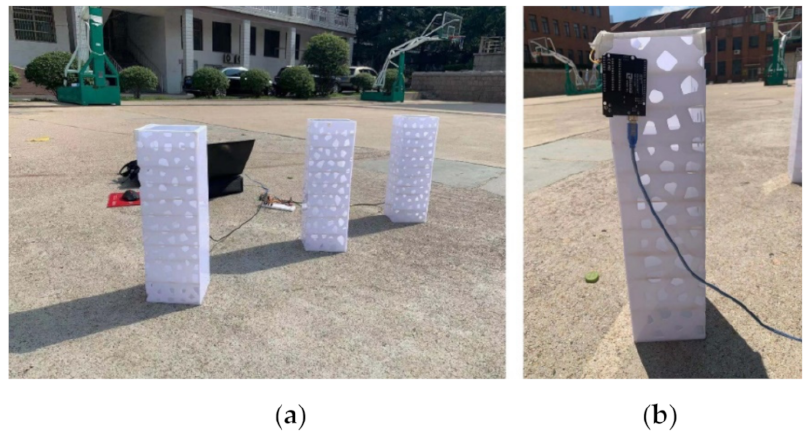
Figure 17. ( a , b ) Physical models with sensors during the experiment.